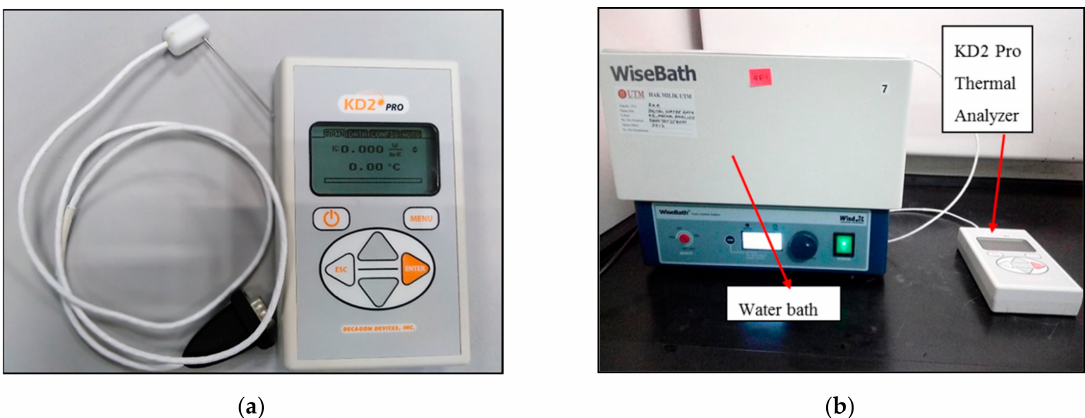
Figure 17. Thermal conductivity instruments: ( a ) Thermal Properties Analyzer, Decagon KD2-Pro Conductivity meter with KS-1 sensor, ( b ) Wise water bath used to conduct thermal conductivity test.